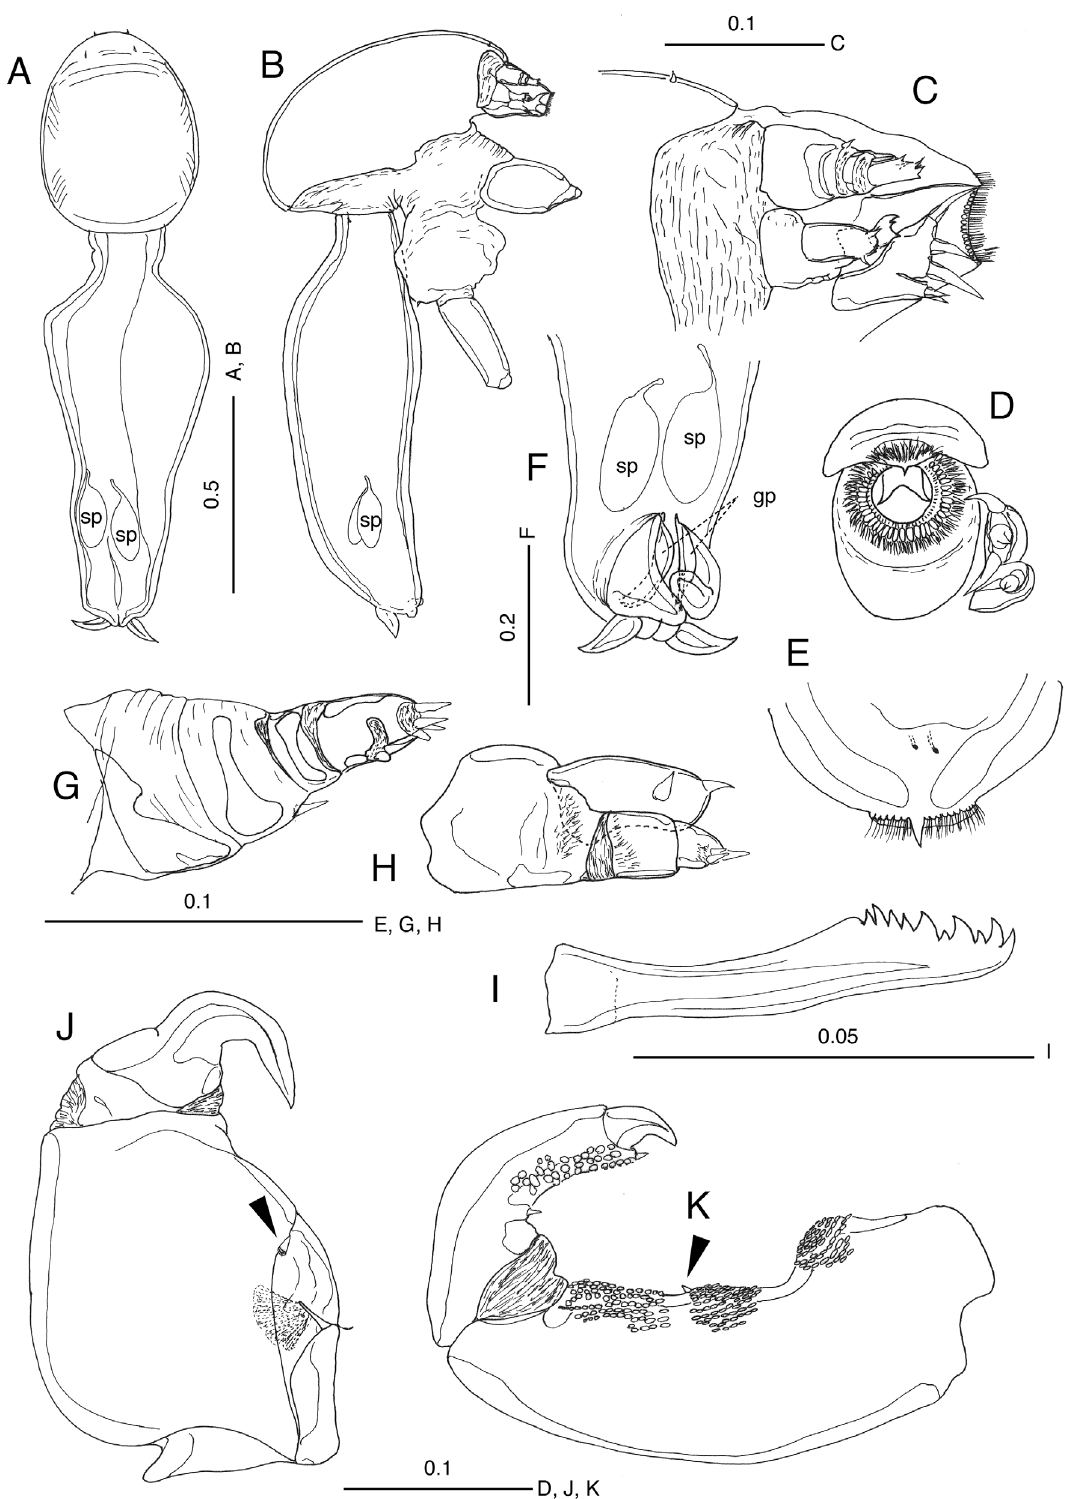
Figure 2. Brachiella malayensis n. sp., male, based on a specimen found from Scomberomorus commerson collected off Besut, Terengganu, Malaysia. (A) Habitus, dorsal view; (B) habitus, lateral view; (C) mouth area, lateral view; (D) oral cone and maxillule, ventral view; (E) labrum, ventral view; (F) genital area, ventral view; (G) antennule; (H) antenna; (I) mandible, (J) maxilla, short element arrowed; (K) maxilliped, short element arrowed. Scales in